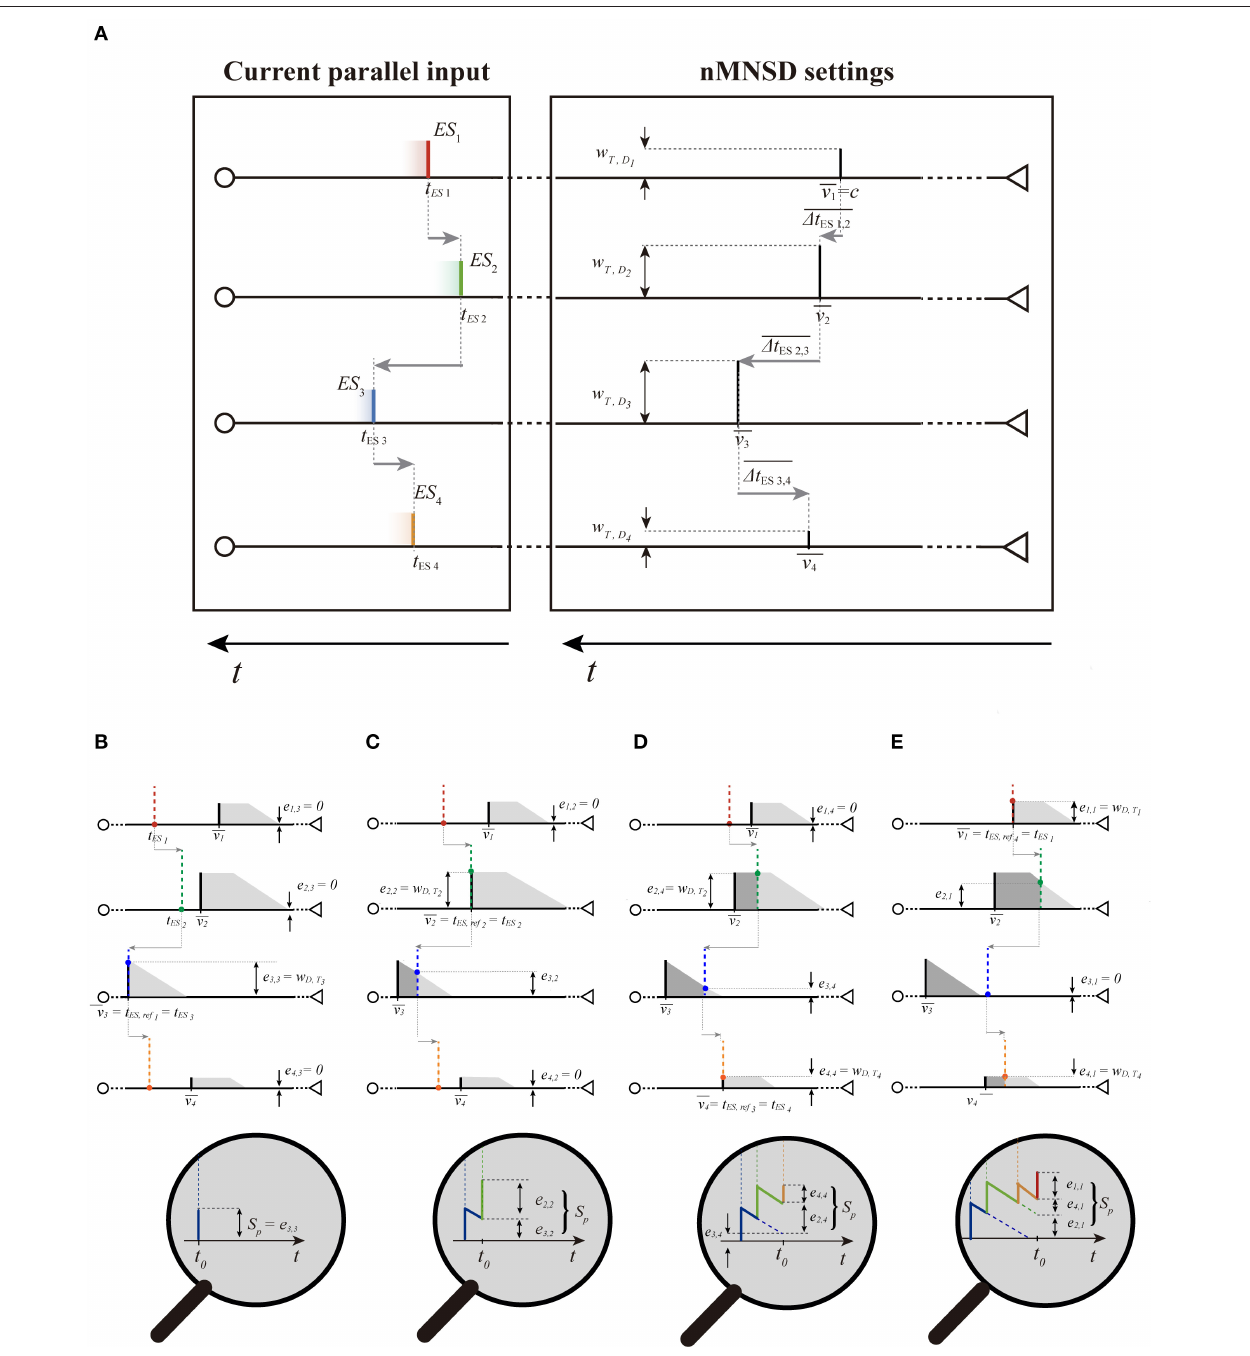
FIGURE 6 | Target summation executed with the trapezoid method. (A) The PPT of a parallel spike train of order 4 (left) moving toward the preferential parallel train (PPT) of the nMNSD settings; the two blocks are here represented separately for ease of understanding. Note that the time axis has to be considered reversed in both the blocks (as in Figure 3 ), since we are portraying the parallel spike train in motion. Envisaging the parallel train sliding toward right we can notice that ESs will cross the PPT of the structure with the following ES order (i.e., the following crossing order): h 3,2,4,1 i . In (B–E) , we give a “stop-motion” representation of the target summation executed with the trapezoid method, showing both the parallel spike train and the trapezoid set of the structure on the same chart (with related zoomed representation of S T below). Except for the trapezoid associated to the first crossing step (which always lacks the rectangle part, as explained in the text), a generic trapezoid has the rectangle length determined by the time difference between its arrival and the end of the trapezoid associated to the last contribution arrived to the target; once the rectangle parts have been drawn, the triangle parts can consequently traced to the right of the rectangle parts to obtain the complete trapezoids. Using the trapezoid method, the efficacies e i , ref to the state of the target neuron S T are directly noticeable on the input of the structure, since they are represented by k the heights of the intersections between the ES and the upper perimeter of the related trapezoid (colored dots). At this point, the summation can be easily decomposed in the contribution of each branch. In the zoom below, the reader can ascertain for the first three crossing steps ( ref 1 = 3, ref 2 = 2, ref 3 = 4) that the computation of the S p through the trapezoid method is equivalent to the one obtained by the classical target summation at the target neuron. Frontiers in Neuroscience |